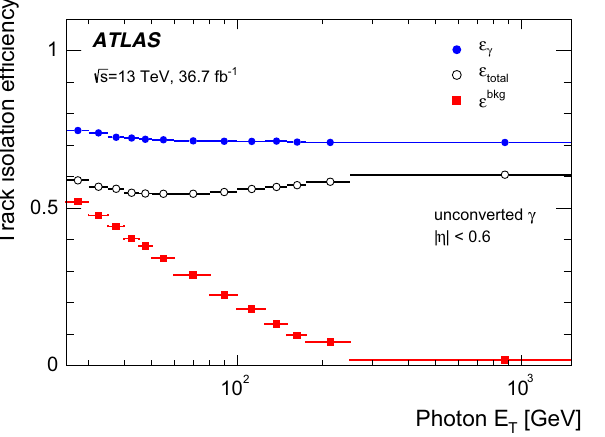
Fig. 6 Left: Track isolation efficiency in the inclusive sample sepa- rately for prompt (blue), fake (red) and all (black) photons for uncon- verted photons in the region | η | < 0 . 6. Right: signal purity P pass for unconvertedphotonssatisfyingthetightidentificationcriteria(blue)and signalpurity P total intheinclusivesample(red)fortheregion | η | < 0 . 6.